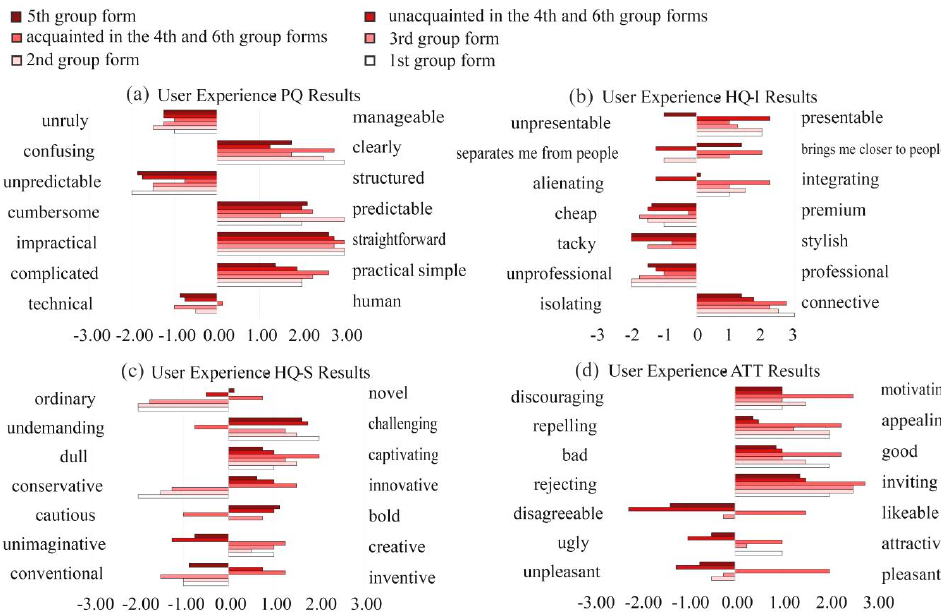
Figure 6. Statistical result of the UES measurement on 6 group forms.